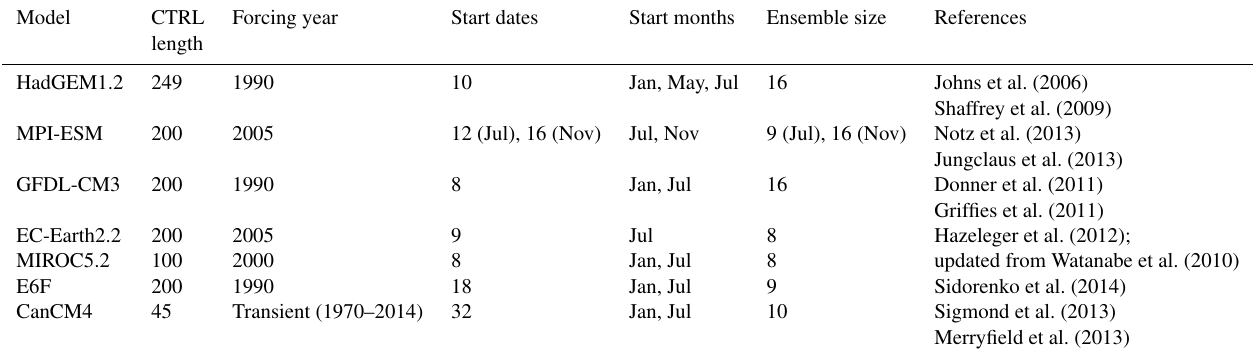
Table 1. Details of simulations submitted to the APPOSITE database.